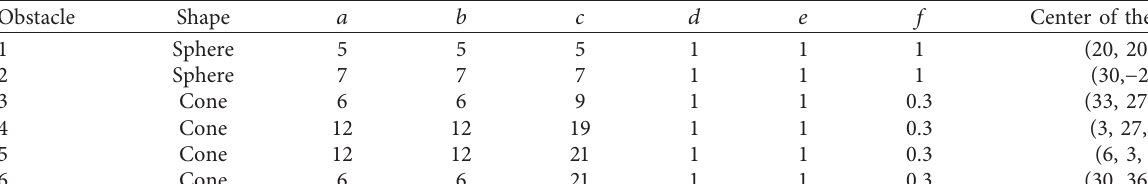
Table 3: The shape parameters of each